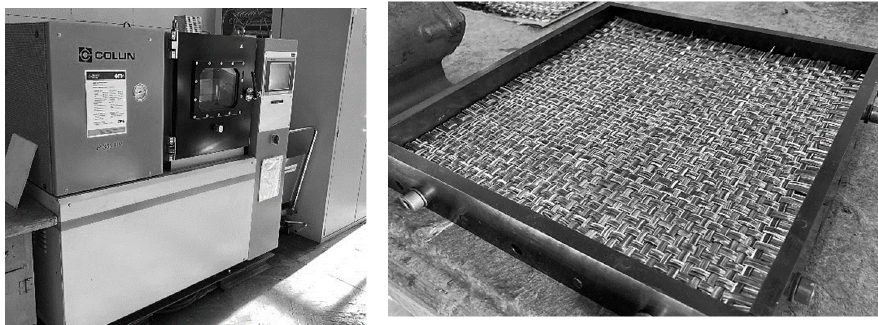
Figure 9. Sample consolidation: laboratory platen-press COLLIN 300 PV and plate tool.